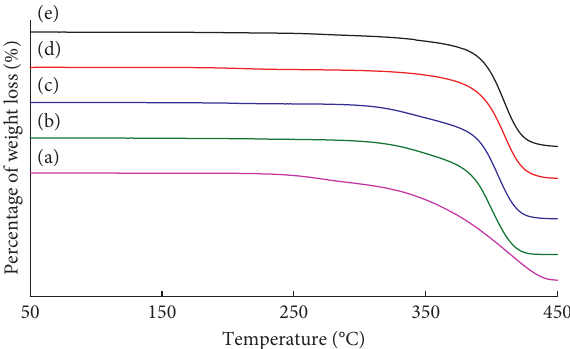
Figure 2: TG curves of (a) pure AG, (b) AG-PEG4000 palmitate- PM, (c) AG-PEG4000 palmitate-SD, (d) AG-PEG8000 palmitate- PM, and (e) AG-PEG8000 palmitate-SD. Table 1: T i and T m of pure AG, physical mixtures (PM) and SD. Sample